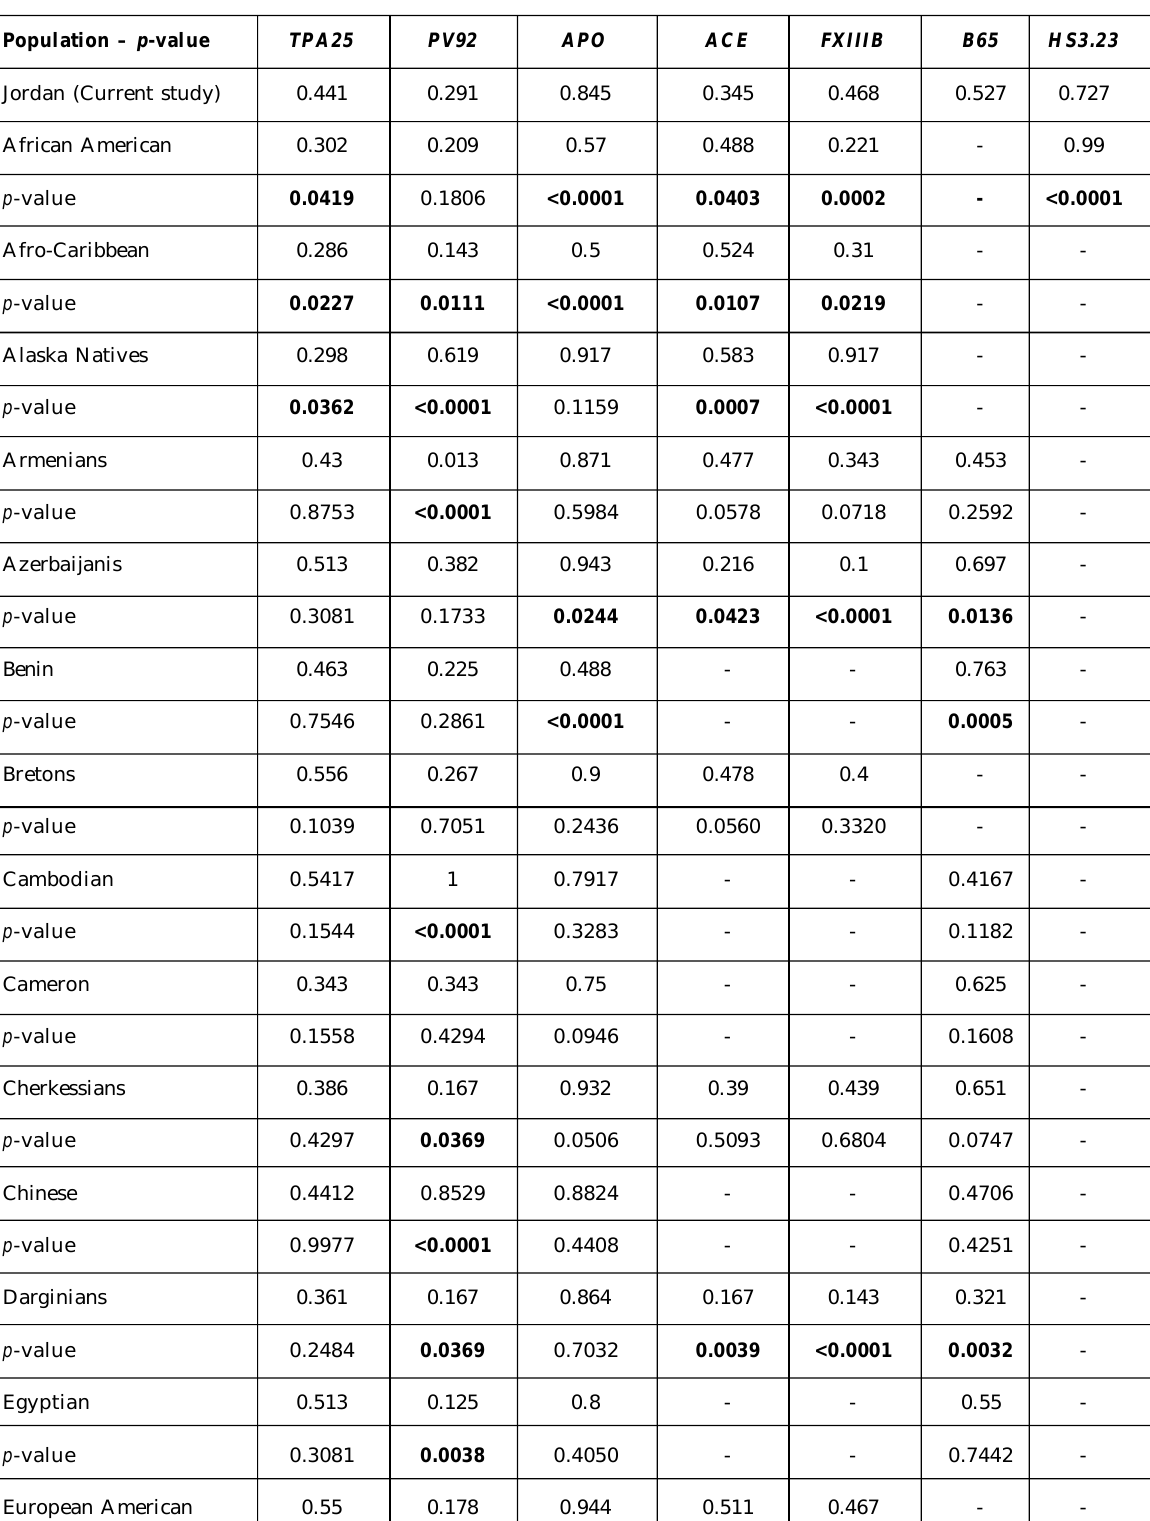
Table 3: Comparison of Alu insertion frequencies between Jordanians and 38 human